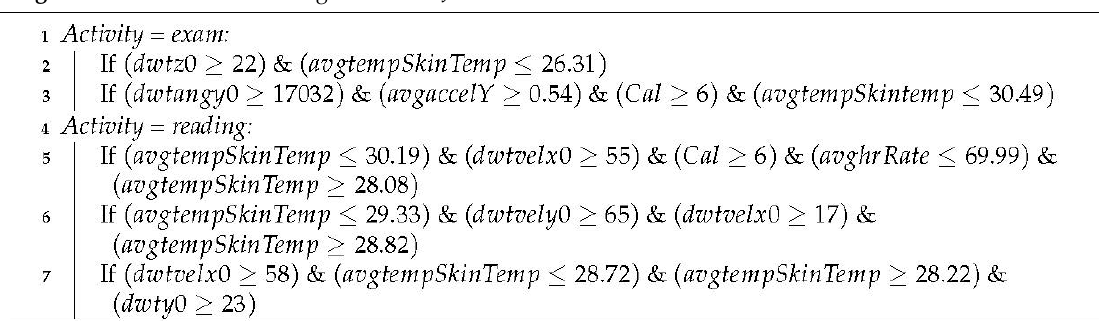
Algorithm 3: Exam and reading rules from JRIP